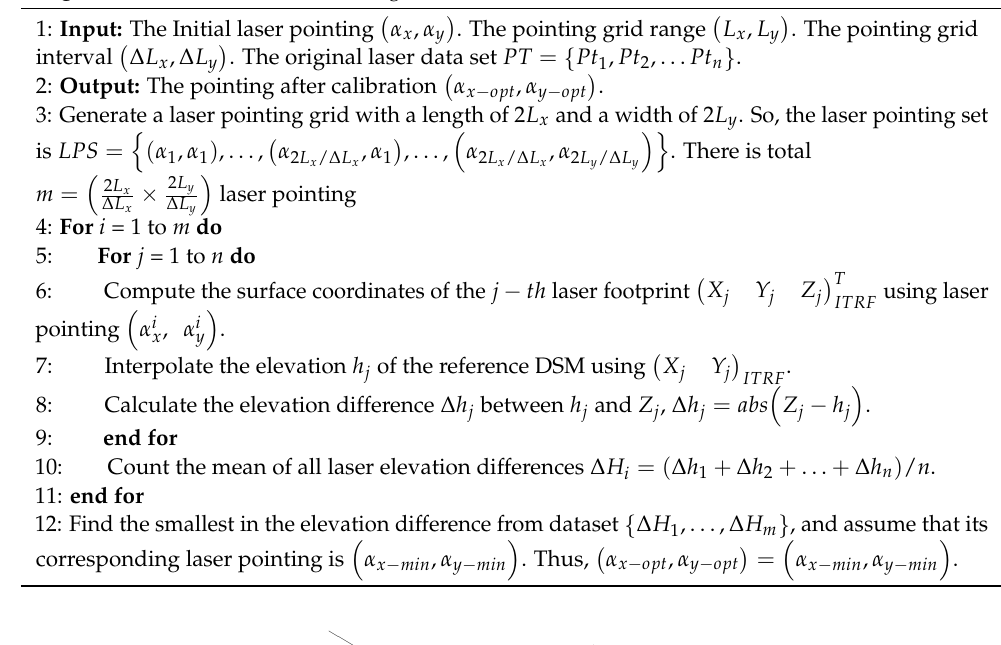
Algorithm 1: Satellite Laser Pointing Calibration